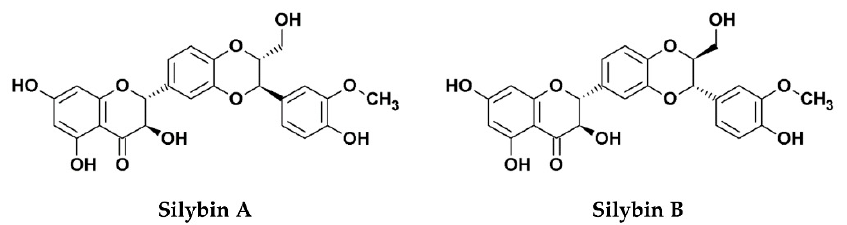
Figure 1. Chemical structures of silibinin, the 1:1 mixture of silybin A and silybin B.